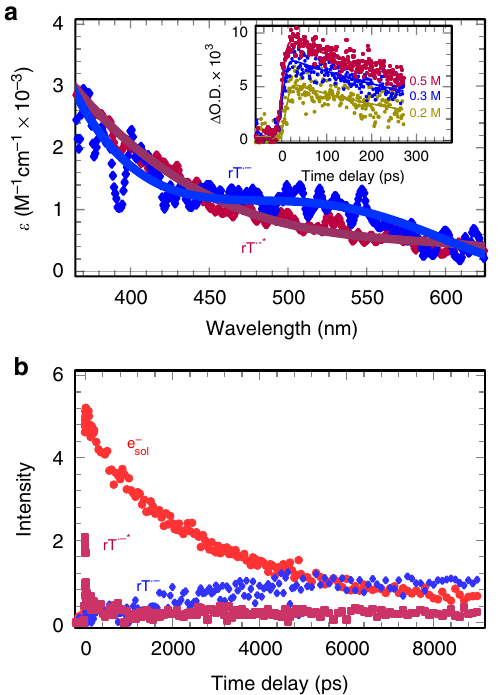
Fig. 4 Deconvolution of absorbing species in a data matrix. a Spectra of excited and ground states of ribothymidine anion radicals, rT (cid:129) ‒ * and rT (cid:129) ‒ , respectively . The inset shows the kinetics of rT (cid:129) ‒ * at different concentrations. b Deconvolution of transient data using a multivariate curve resolution alternating least squares (MCR-ALS) method representing the kinetics of rT (cid:129) ‒ *, rT (cid:129) ‒ , and the solvated electron (e sol¯